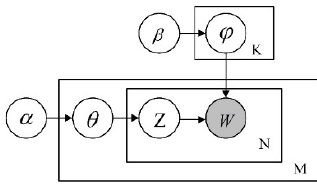
Figure 4. LDA graph model representation.